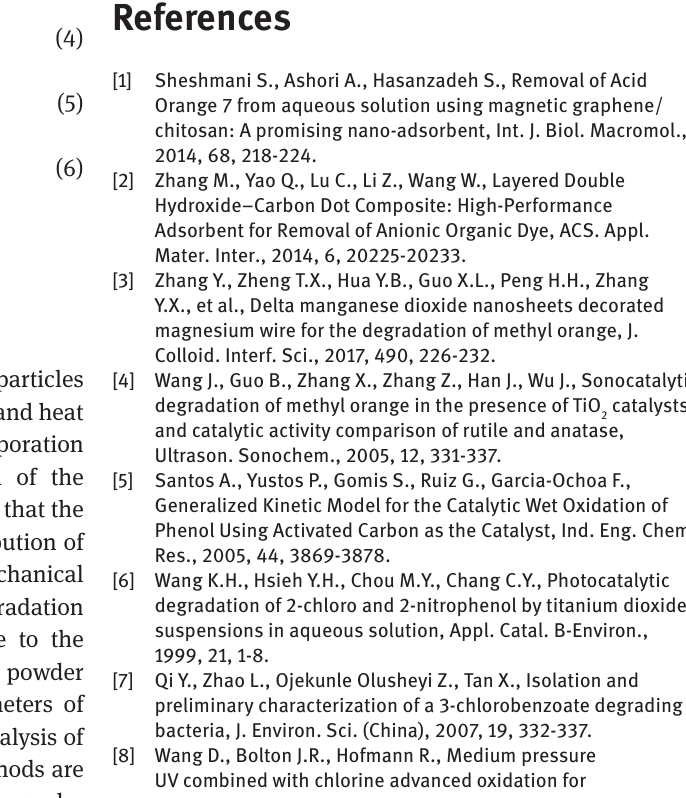
Figure 11: Effect of scavenging compounds on methyl orange sonocatalytic degradation rate (Ethanol = 0.6 M, Sodium chloride= 0.06 mM)